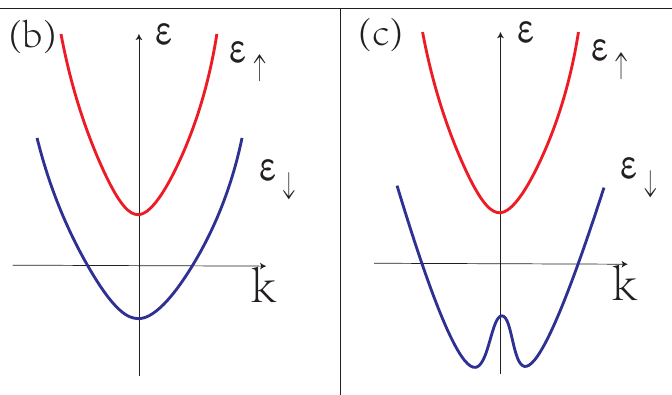
Figure 1. ( a ) Bands splitting with opposite spins; and bands diagram when ( b ) α k J < J , ( c ) α k J > J